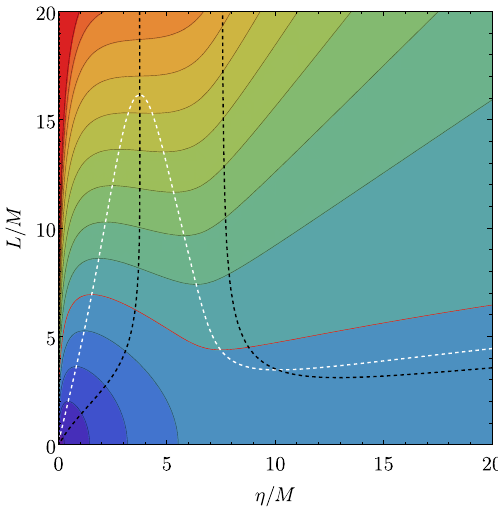
Fig. 26 Contours of V eff in the L – η plane for parameters Q / M = 1, Fig. 28 Same as Fig. 26 for parameters Q / M = 2, λ/ M 2 = 45 λ/ M 2 = 3. The solid red contour shows V = 1, the dashed white and eff black lines show ∂ η V eff = 0 and ∂ 2 η V eff = 0, respectively. The crossings of the white and black lines indicate the critical angular momenta L crit . The crossings of the red line and the maxima indicate the reflective angular momenta L refl . The contour differences are (cid:20) V eff = 0 . 2